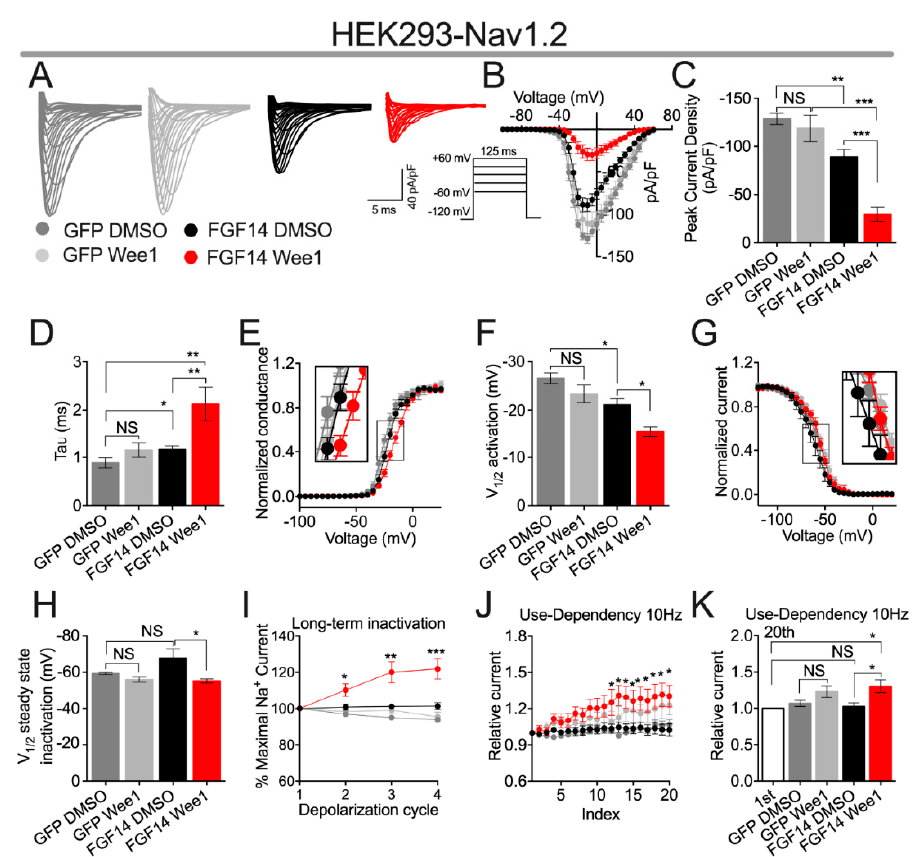
Figure 2. Functional evaluation of the effects of Wee1 inhibitor II on Na v 1.2-mediated currents. ( A ) Representative traces of I Na from cells of the indicated experimental groups in the response to the depicted voltage-clamp protocol. ( B ) Current–voltage relationships of cells from the experimental groups described in ( A ). ( C , D ) Comparison of peak I Na density ( C ) and the tau of fast inactivation of I Na ( D ) of cells from the indicated experimental groups. ( E ) Normalized conductance plotted as a function of voltage to characterize the voltage-dependence of Na v 1.2 channel activation of cells from the experimental groups described in ( A ). Data were fitted with the Boltzmann equation to determine V 1/2 of activation. ( F ) Bar graph derived from ( E ) comparing V 1/2 of activation among the indicated experimental groups. ( G ) Normalized current plotted as a function of voltage to characterize the voltage-dependence of Na v 1.2 channel steady-state inactivation of cells from the experimental groups described in ( A ). Data were fitted with the Boltzmann equation to determine V 1/2 of steady-state inactivation. ( H ) Bar graph derived from ( G ) comparing V 1/2 of Na v 1.2 channel steady-state inactivation among the indicated experimental groups. ( I ) Percentage maximal I Na (normalized to the I Na amplitude observed during the first depolarization) plotted as a function of depolarization cycle to characterize the effects of Wee1 inhibitor II on the entry of Na v 1.2 channels into long-term inactivation in the experimental groups described in ( A ). ( J ) Relative current (normalized to the I Na amplitude observed during the first depolarization) plotted as a function of depolarization cycle to characterize the effects of pharmacological inhibition of Wee1 kinase on the cumulative inactivation of Na v 1.2 channels for the experimental groups described in ( A ). ( K ) Bar graph comparing the ratio of the I Na amplitude observed during the first depolarization normalized to the I Na amplitude observed during the 20th depolarization for the indicated experimental groups. Data are mean ± SEM. Significance was assessed using a one-way ANOVA with post-hoc Tukey’s multiple comparisons test. *, p < 0.05; **, p < 0.01; *** , p < 0.001. Data are summarized in Tables 1 and 2.